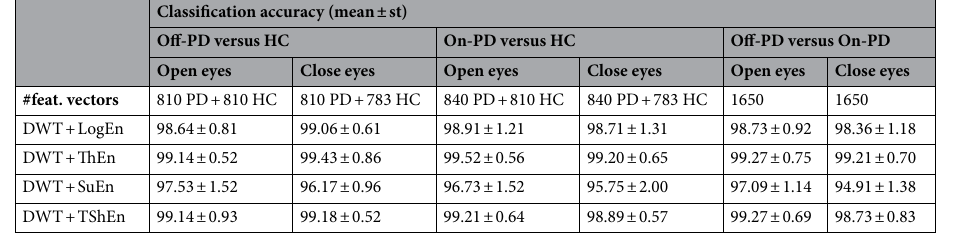
Table 10. Classification results using KNN classifier (UNM